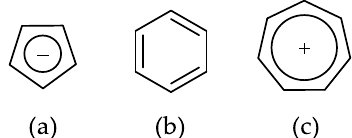
Scheme 1. Six π -electron monocyclic hydrocarbons: cyclopentadienyl anion ( a ), benzene ( b ), and cycloheptatrienyl cation ( c ).